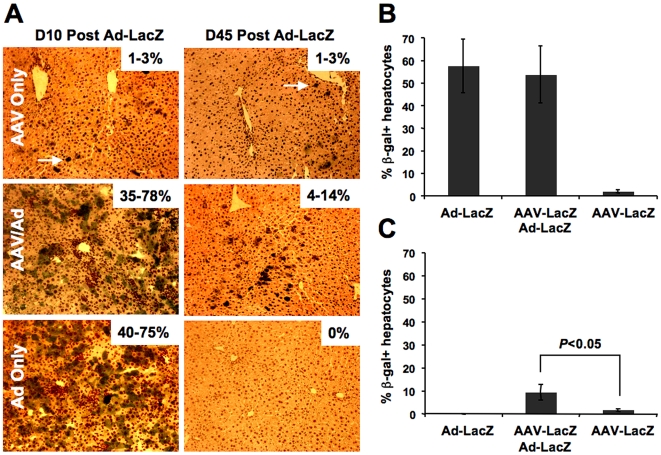
Expression of β-gal in viral vector transduced livers.Sections from C57BL/6 mice (3 per animal; separated by 24 microns) were stained for β-gal enzyme activity and counterstained with hemotoxylin nuclear stain. A. Representative images of livers from AAV-LacZ transduced mice (6 weeks or 12 weeks after gene transfer); AAV-LacZ/Ad-LacZ transduced mice (10 days or 45 days after Ad-LacZ administration, which occurred 6 weeks after the initial AAV-LacZ gene transfer); and Ad-LacZ only transduced mice (10 and 45 days after gene transfer). Arrows point toward examples of β-gal+ hepatocytes in AAV-LacZ only transduced livers. Original magnification: 100x. B-C. Percentages of β-gal expressing hepatocytes at day10 (B) or day 45 (C) after Ad-LacZ gene transfer. Data are average±SD for n = 4 mice/experimental group.